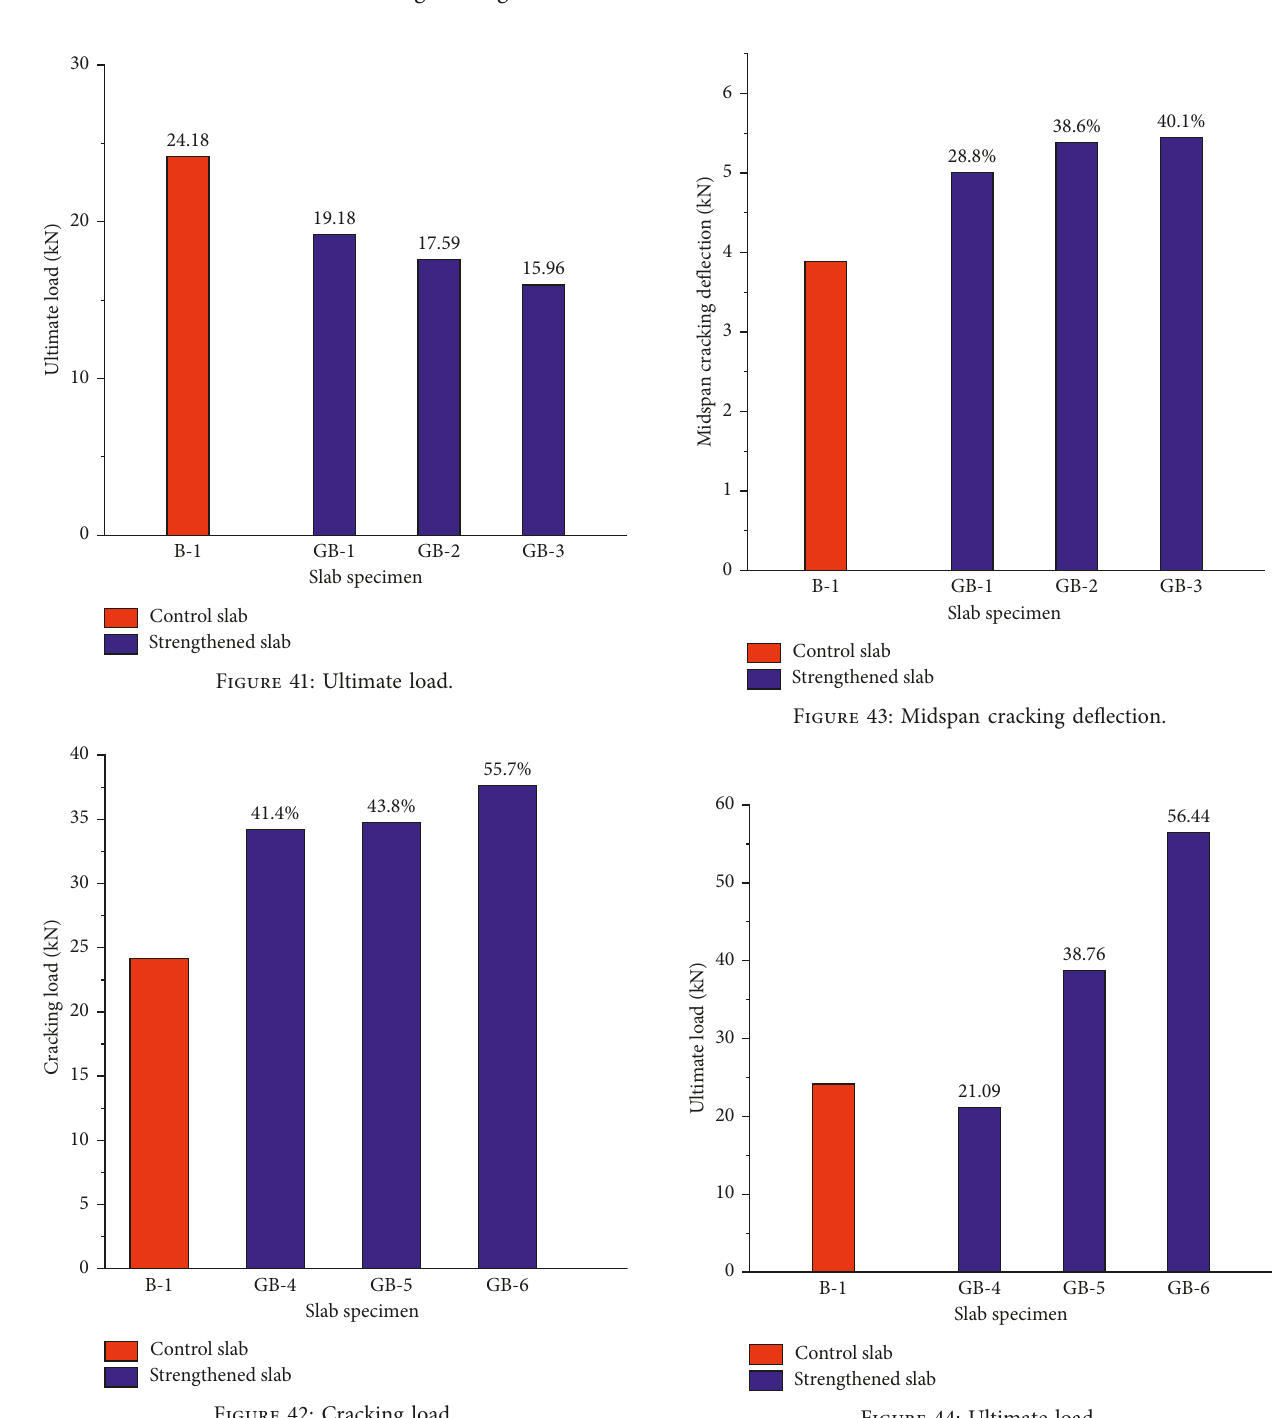
Figure 42: Cracking load. Figure 44: Ultimate load.